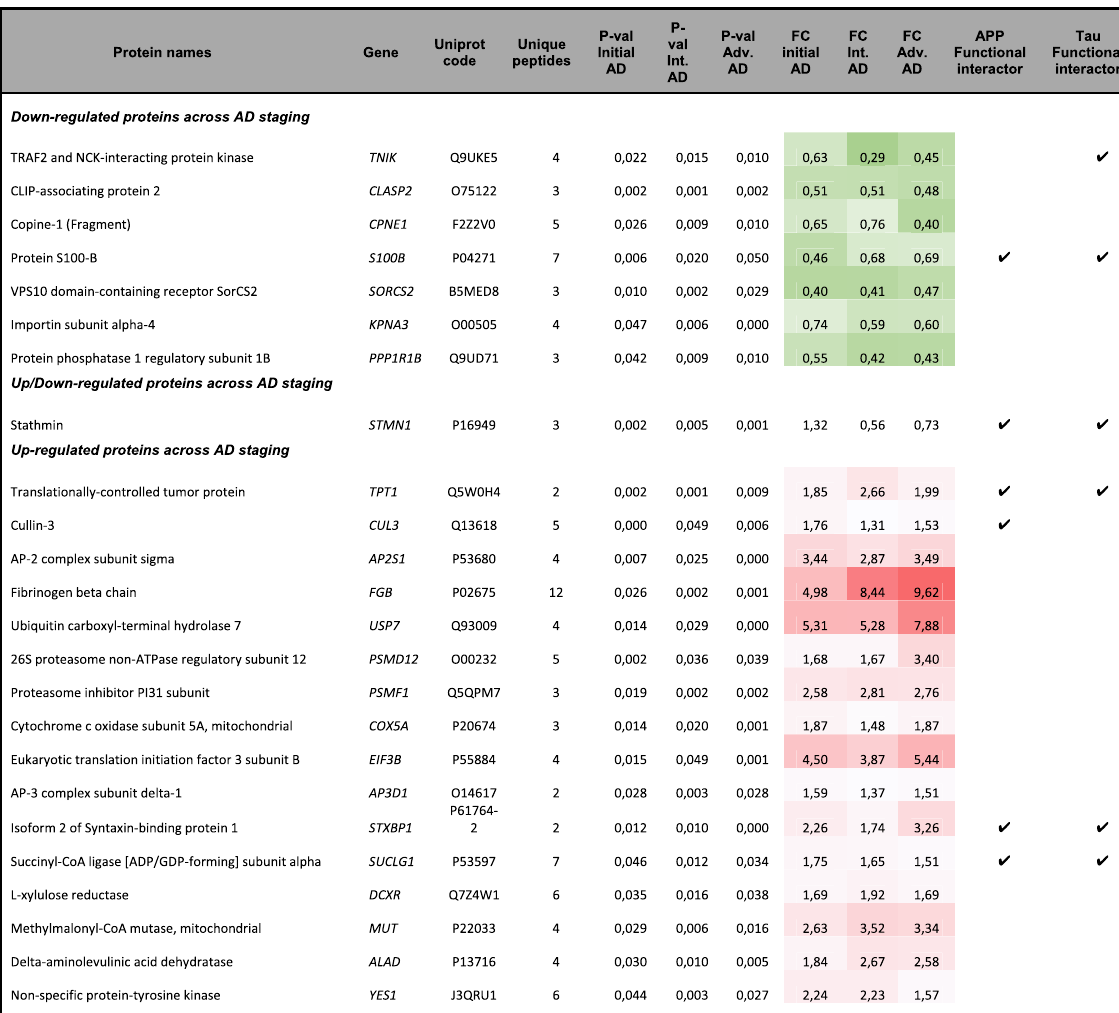
Table 2. Common differential expressed OB proteins across AD stages. The fold-change (FC) of differential proteins with associated p-values from the pair-wise comparisons of control vs each AD stage, together with Protein/gene names, protein code by Uniprot, and unique peptides used for quantitation are shown. The significant downward or upward trend is represented in green or red color respectively. Proteins that are functional interactors of APP and Tau proteins are also